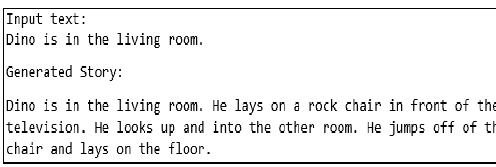
Fig. 4.3. Expected Text Output on Flintstones